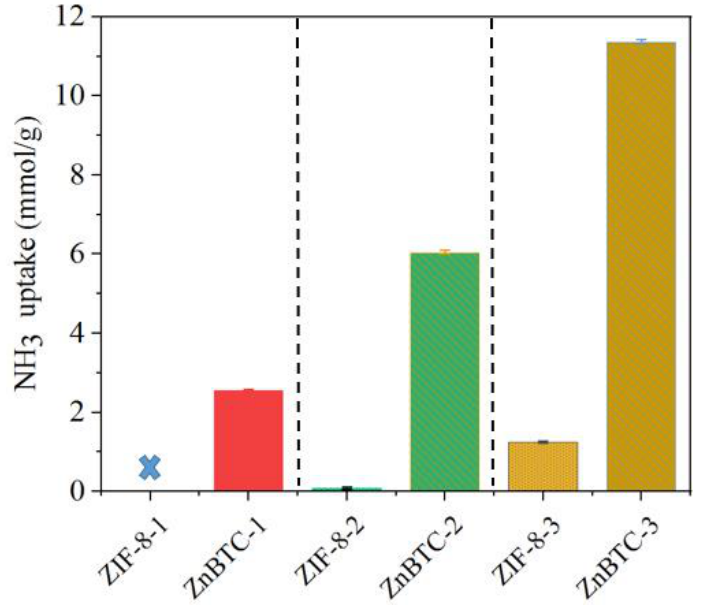
Figure 5. NH 3 adsorption capacity of ZIF-8 and ZnBTC in different settings.